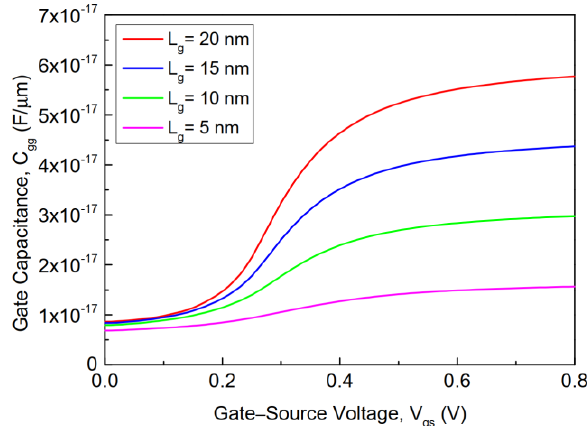
Figure 17. Gate capacitance as a function of gate – source voltage with different gate lengths at V ds = 0.05 V.